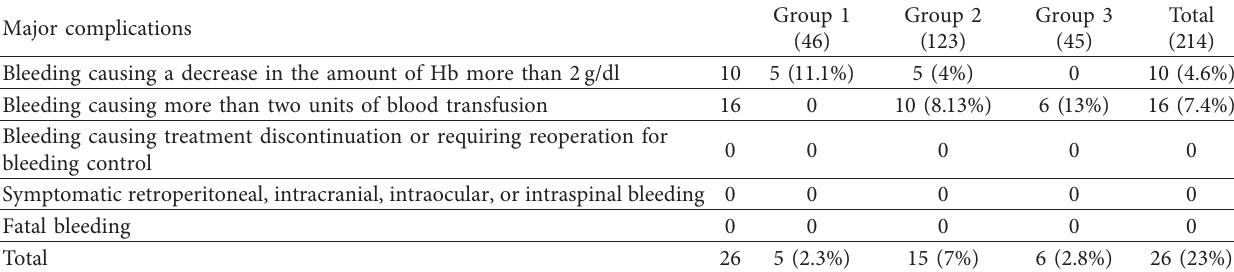
Table 1: Distribution of major complications